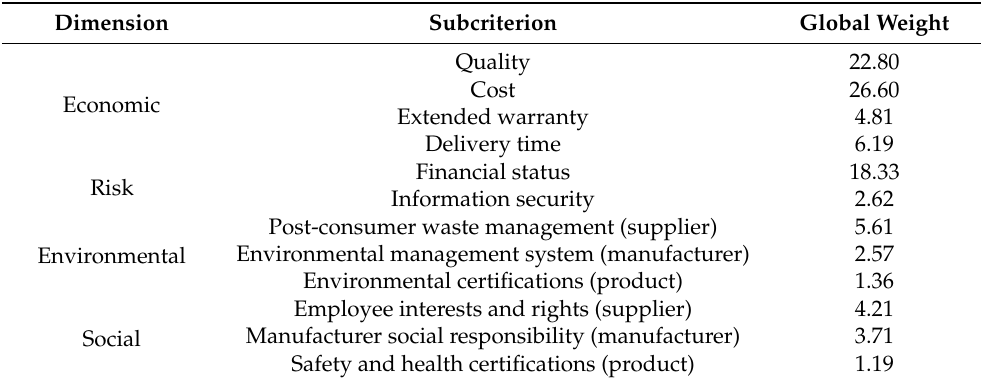
Table 2. Weights of criteria in the supplier